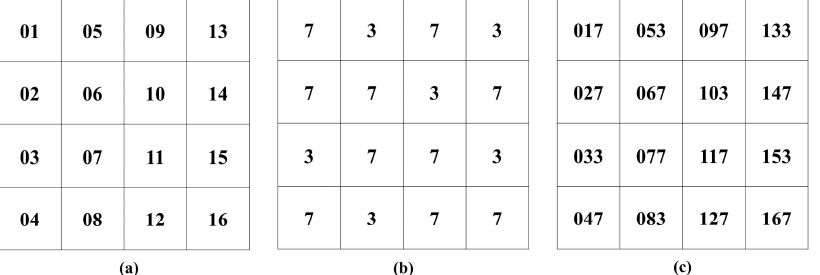
Figure 2. Watermark with fused watermark indexes and bits. ( a ) Fixed length index; ( b ) mapped bits; ( c ) final watermark values.